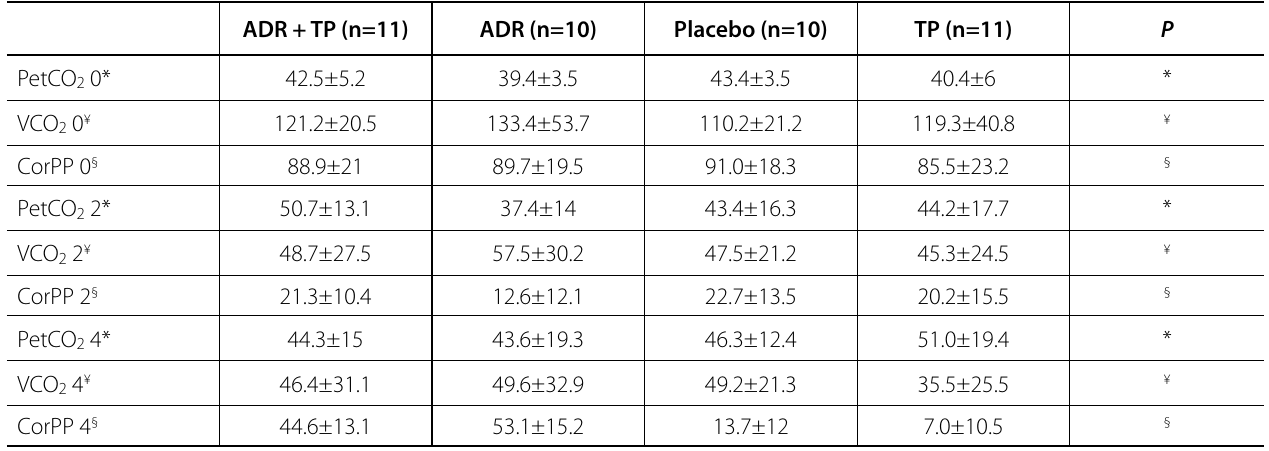
Table 1. Descriptive analysis and comparisons of the variables assessed at baseline (0), 2 min of CPR (2), and 4 min of CPR (4) within and among groups. ADR + TP (n=11) ADR (n=10) Placebo (n=10) TP (n=11) P PetCO 2 0*